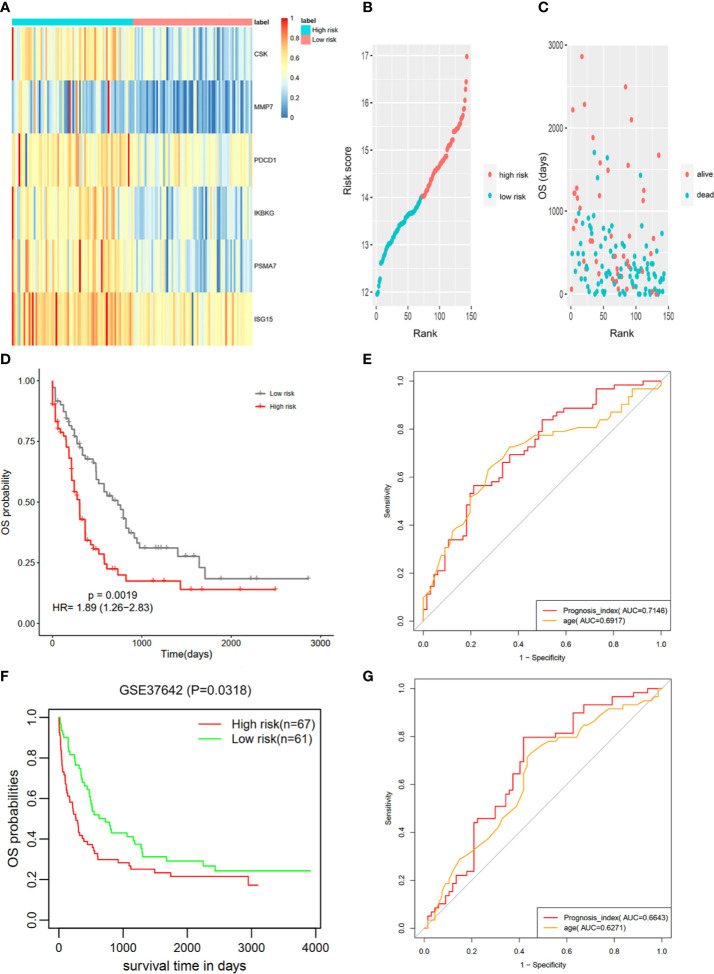
Construction of the 6 IRG signature. (A) The expression of 6 IRGs in the high and low risk score group is shown using a heatmap. (B, C) The relationship between the risk score, OS and living status. (B) Patients were ranked based on risk score. (C) Higher risk score was found to be associated with more deaths and shorter OS. (D) Based on data from TCGA database, the Kaplan-Meier curve showed that patients in the high risk group exhibited significantly shorter OS than patients in the low risk group [P = 0.00019, HR = 1.89 (1.26–2.83)]. (E) The AUC of the signature was 0.7146. (F) The signature was further validated using an independent GEO dataset (GSE37642). The Kaplan-Meier curve demonstrated that patients in the high risk score group exhibited significant shorter OS than those in the low risk score group. (G) The AUC was 0.6643.